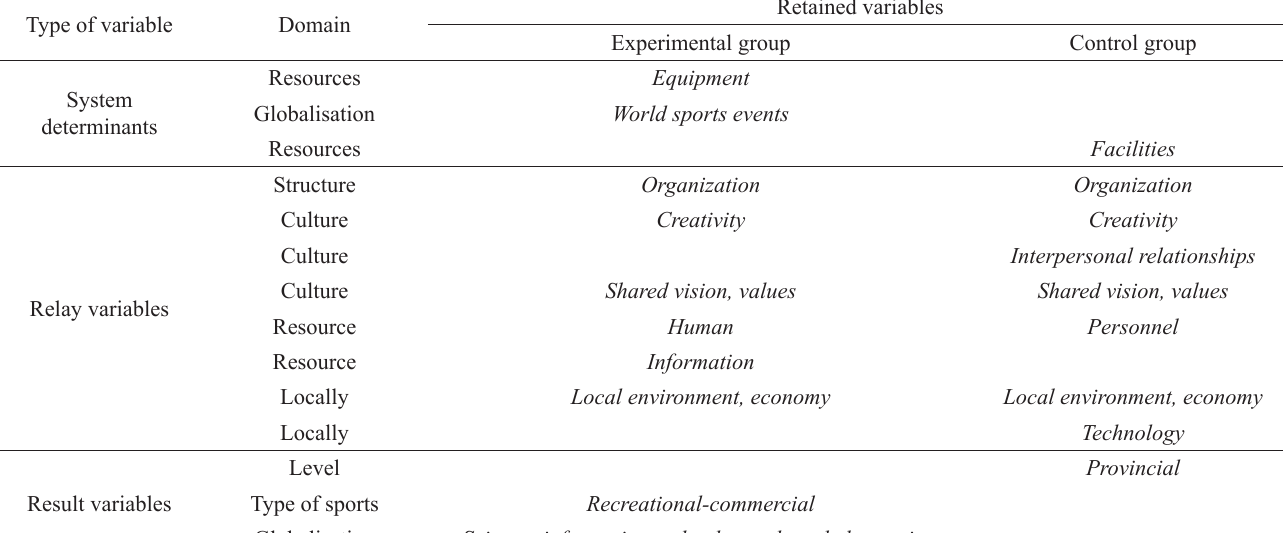
Table 1. Key variables identified based on the analysis of meaningful core of the system.